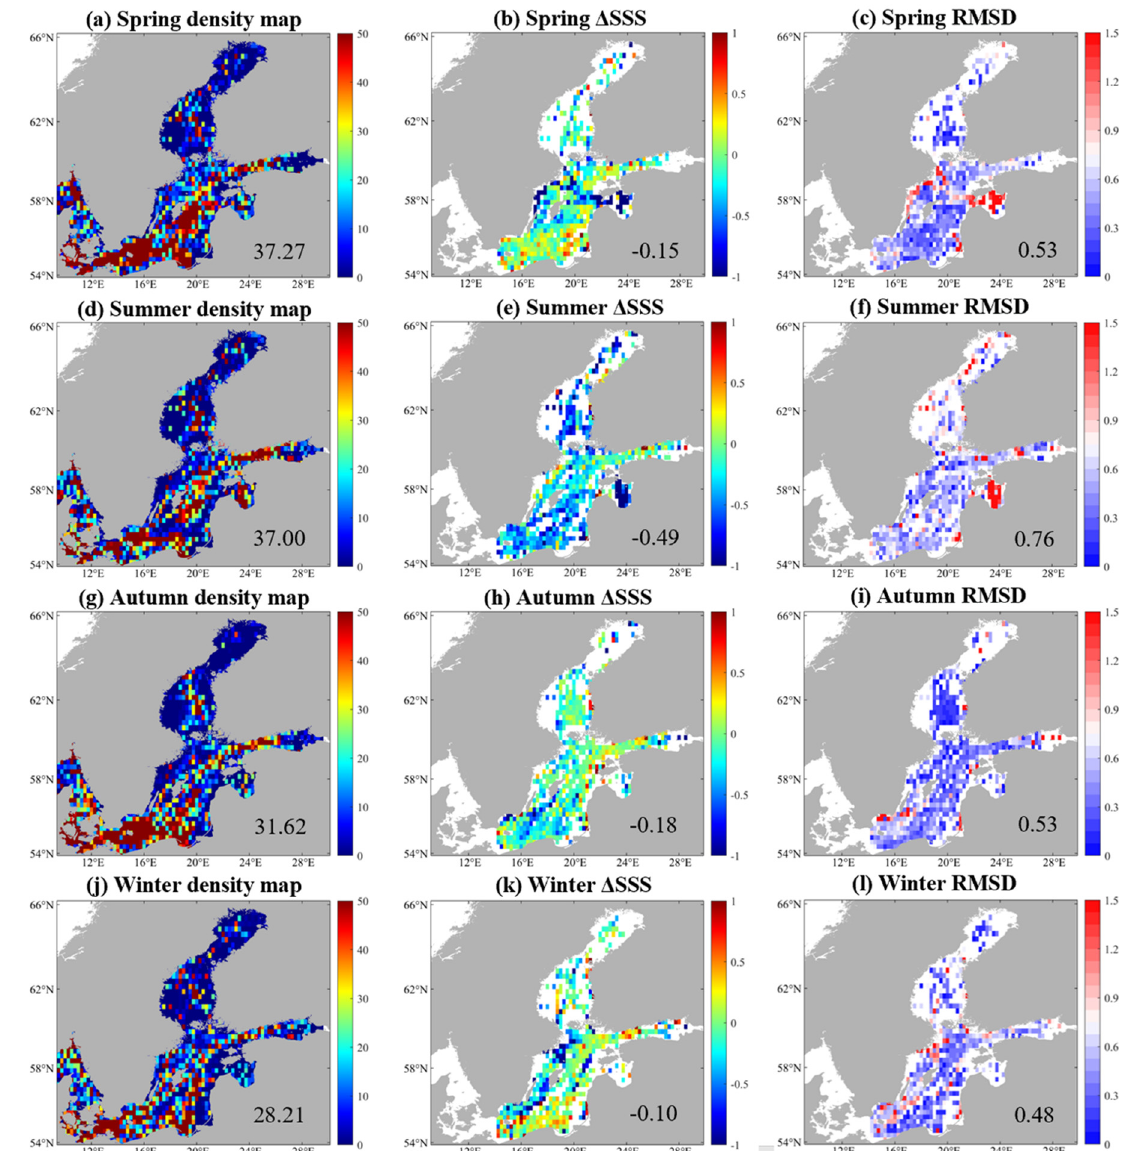
Figure 5. Spatial distribution of the data volume ( a,d,g,j ), mean Δ SSS values ( b,e,h,k ) and RMSDs ( c,f,i,l ) between the Baltic+SSS L4 data and collocated in situ SSS measurements. From top to bottom: Spring (March, April and May), Summer (June, July and August), Autumn (September, October and November) and Winter (December, January and February). The numbers labeled in the lowest right are the spatial average SSS (left), Δ SSS (middle) and RMSD (right) values. The unit is in PSU for Δ SSS and RMSD.